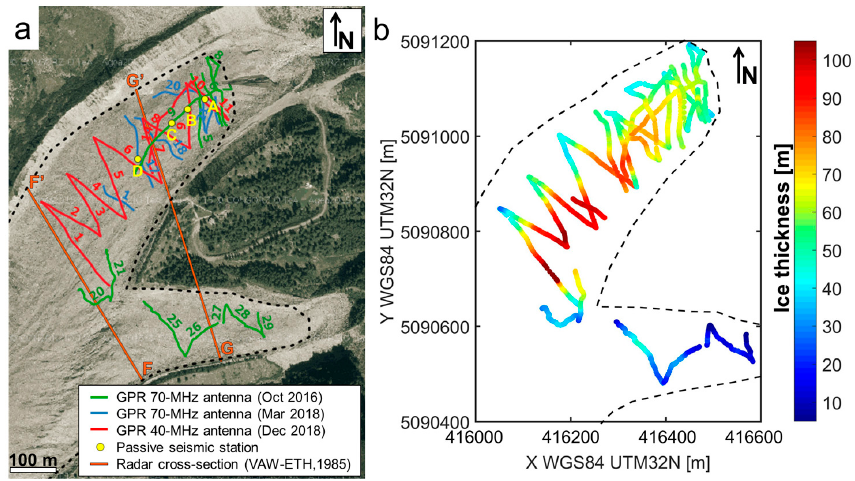
Figure 6. ( a ) Summary of the GPR profiles for which ice bottom picking was retrieved. ( b ) Map of the resulting ice bottom picks.